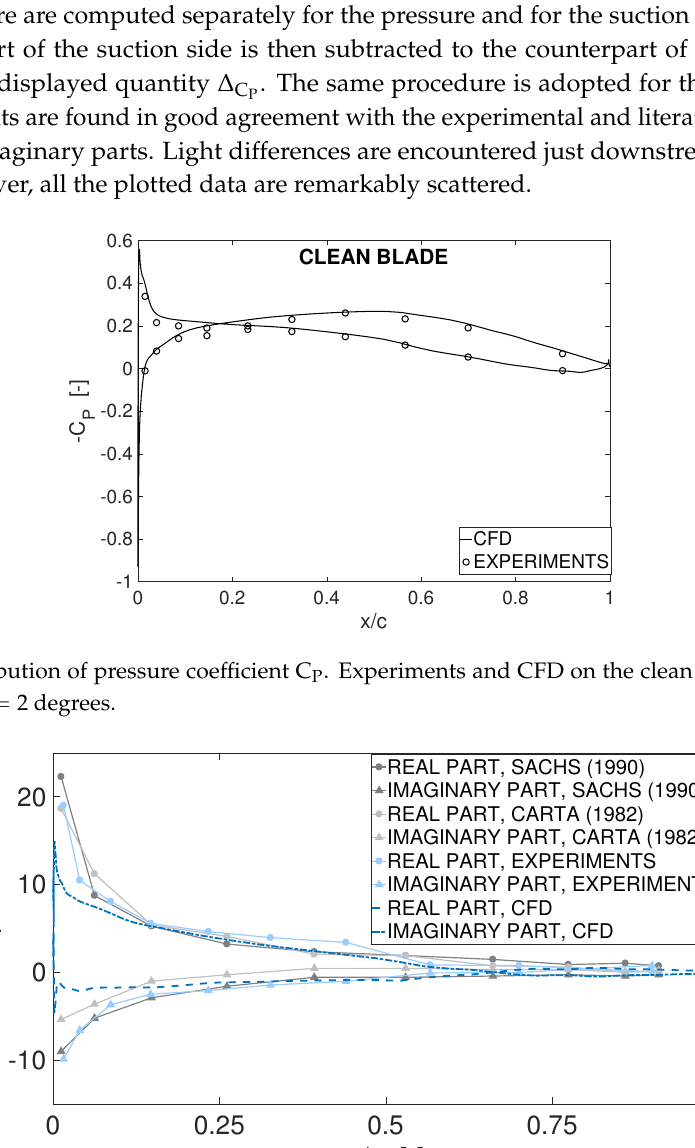
) degrees; f = 5.25 Hz; 180